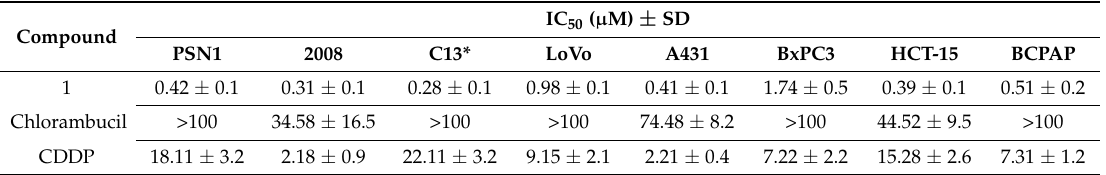
Table 1. Cytotoxicity against human cancer cell